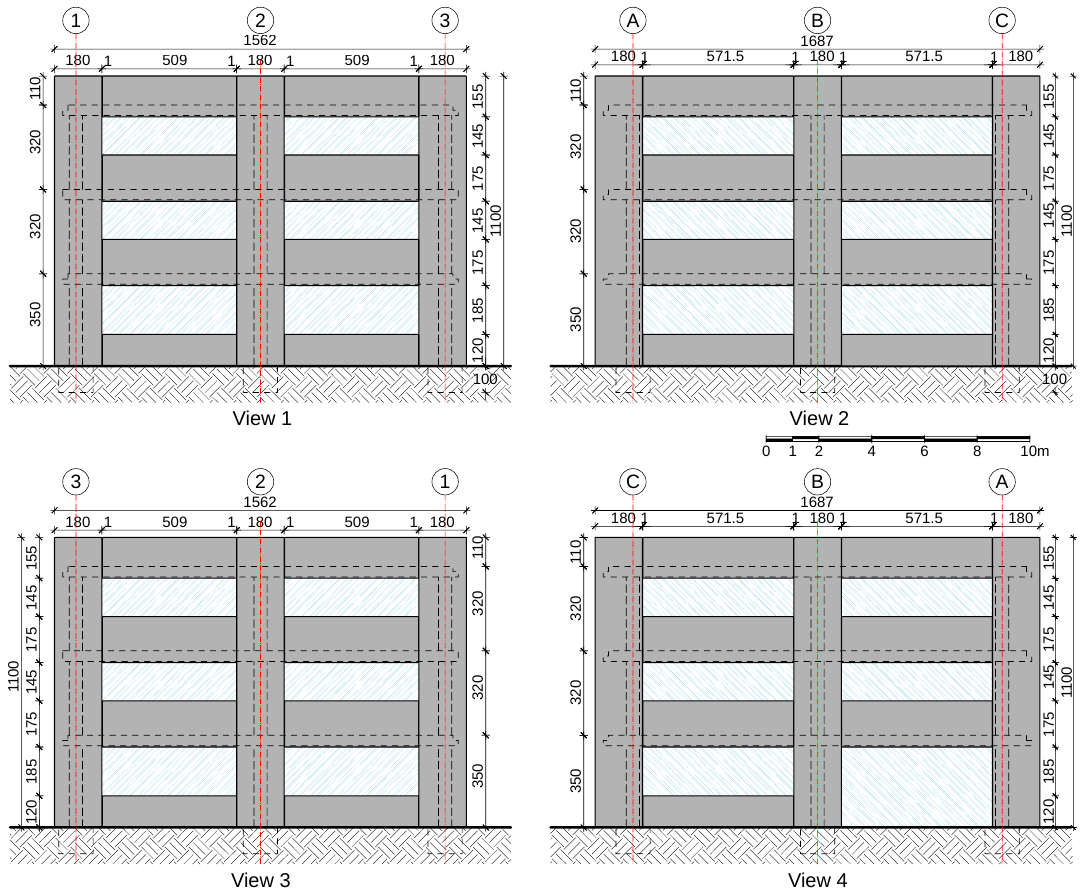
Figure 8. Structural plan and view of the cladding system in the precast